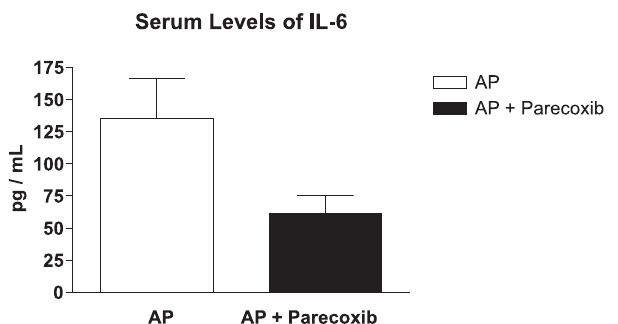
Figure 2 - Effect of Cox-2 inhibition on serum levels of IL-6, evaluated by an ELISA method, showing lower levels in parecoxib-treated rats (AP: Mean ± SEM = 135.6 ± 31.14, n = 7; and AP + Parecoxib: Mean ± SEM = 61.64 ± 14.19, n =14 ( P = 0.0216).